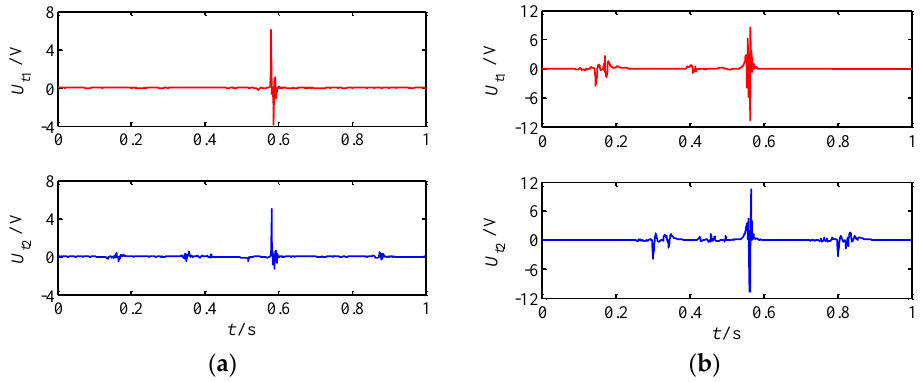
Figure 6. Test results of output voltage under transient excitation. ( a ) R = 10 kΩ; ( b ) R = 40 kΩ.